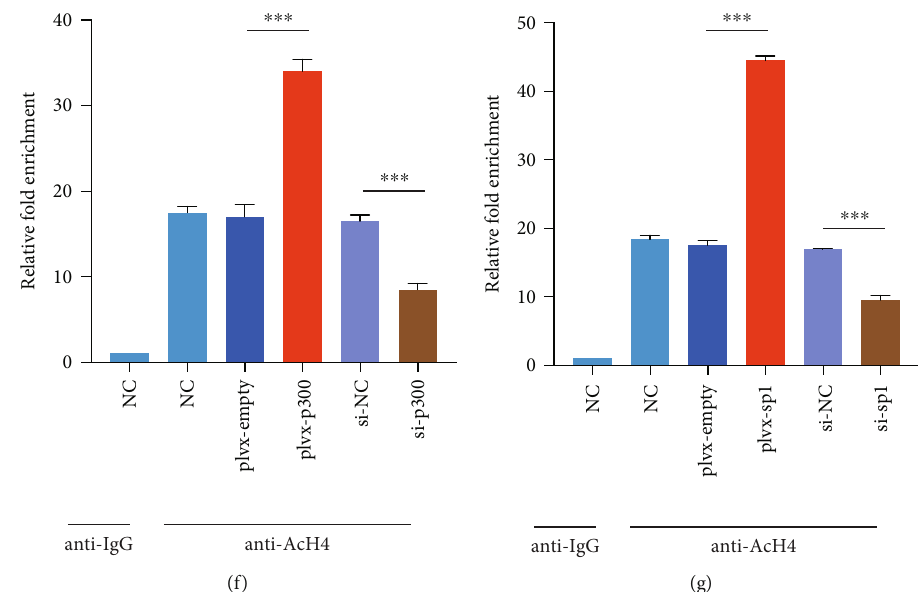
Figure 5: p300/Sp1 regulated p16 transcriptional activity. (a) Di ff erent amounts of p300 were overexpressed in EPCs, and the activity of the p16 promoter was detected by luciferase. (b) Di ff erent amounts of Sp1 were overexpressed in EPCs, and the activity of the p16 promoter was detected by luciferase. (c) p300/Sp1 were knocked down in EPCs, and the activity of the p16 promoter was detected by luciferase. (d) p300/Sp1 were overexpressed or knocked down in EPCs, and the expression of p16 was detected by RT-PCR. (e) p300/Sp1 were overexpressed or/and knocked down in EPCs, and the expression of p16 was tested by Western Blot. (f) p300 was overexpressed or/and knocked down in EPCs, and the level of histone H4 acetylation in the p16 promoter region was detected by ChIP assay. (g) Sp1 was overexpressed or/and knocked down in EPCs, and the level of histone H4 acetylation in the p16 promoter region was detected by the ChIP assay. All the EPCs used in this fi gure were from nonsmoking non-COPD patients. ∗ p < 0 : 05 , ∗∗ p < 0 : 01 , and ∗∗∗ p < 0 : 001